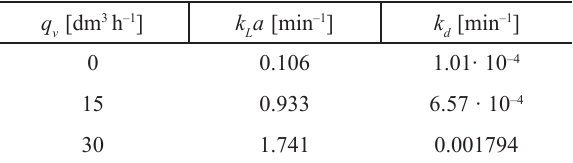
Table 4 – Free GOD operational stability decay rate con- stants at different aeration rates estimated from the